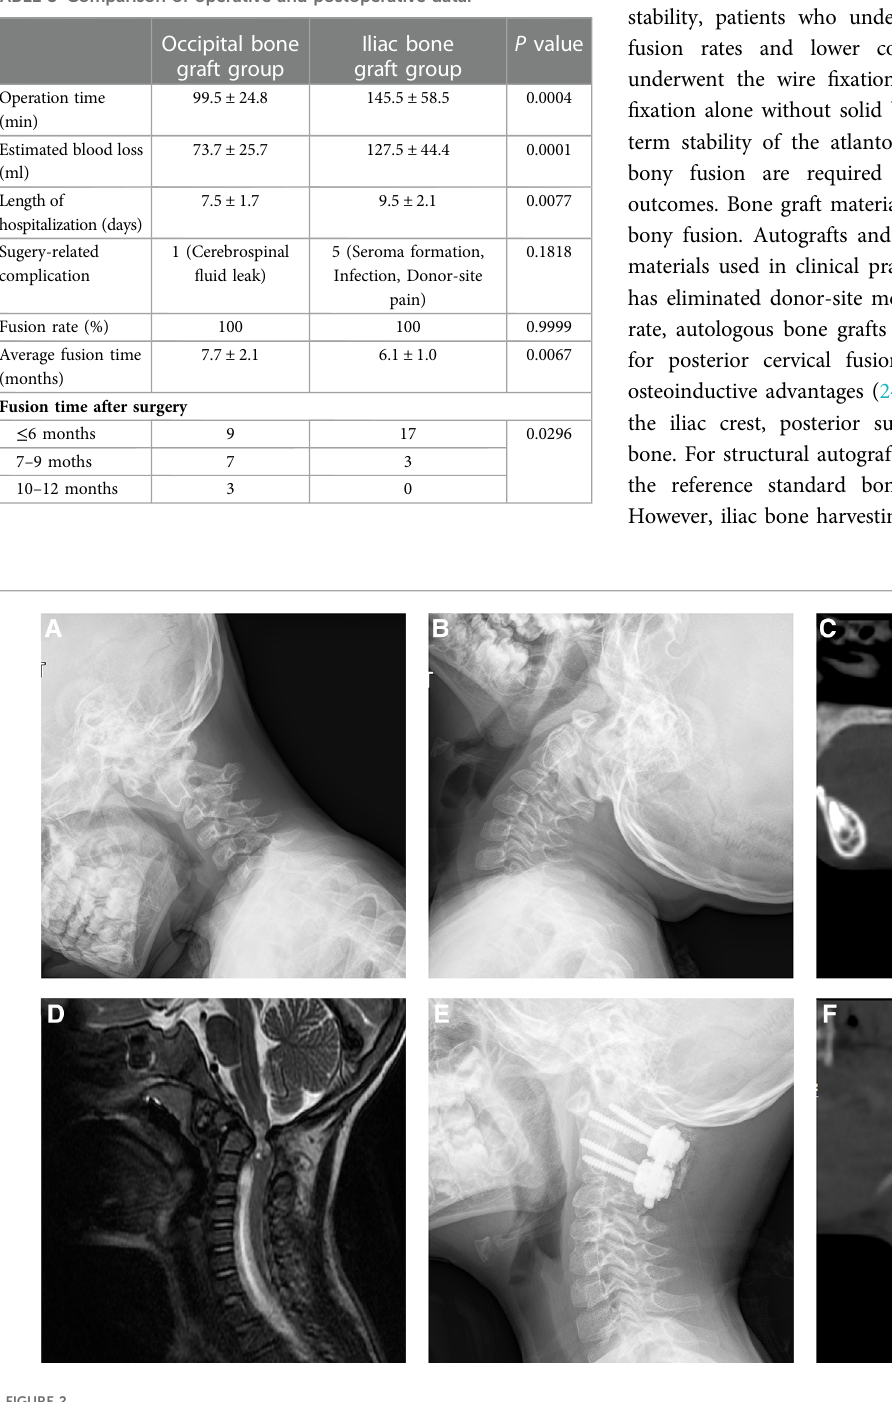
FIGURE 2 Images of a 5-year-old boy diagnosed of os odontoideum and underwent atlantoaxial fusion with the use of IBG. Preoperative plain radiograph of fl exion ( A ) extension ( B ) showed atlantoaxial dislocation. Preoperative CT showed os odontoideum ( C ). Preoperative magnetic resonance imaging (MRI) showed spinal cord compression ( D ). Postoperative plain radiograph ( E ) showed the rigid screw/rod fi xation. CT sagittal reconstruction showed solid bony fusion 6 months after surgery ( F